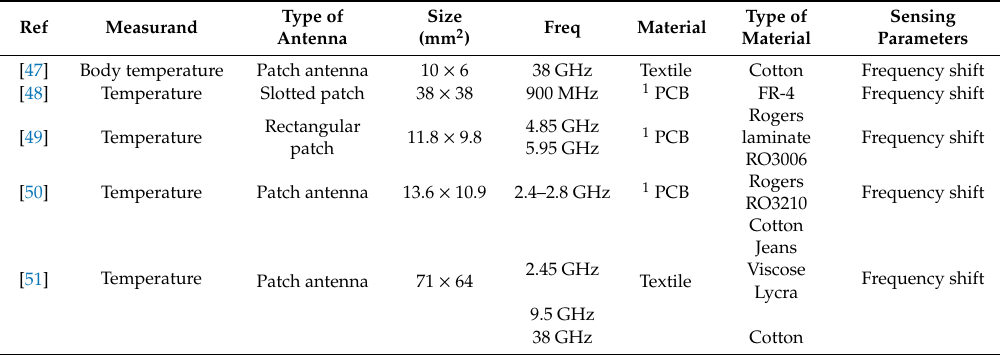
Table 3. Summary of previously reported works on antenna temperature